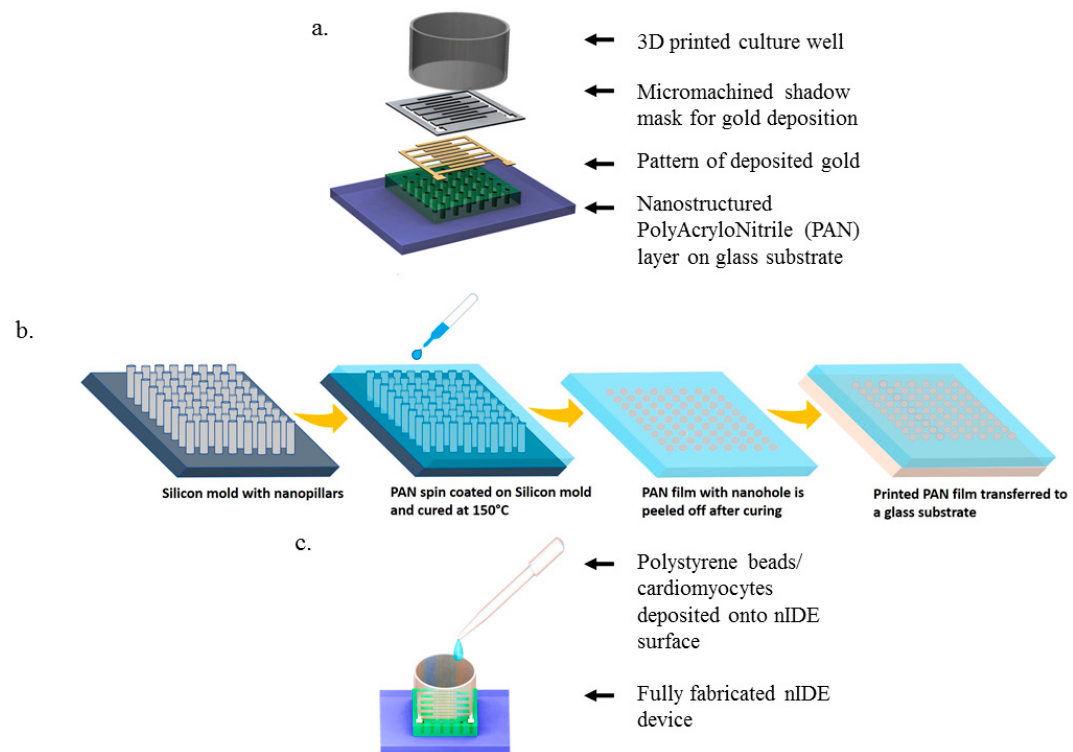
Figure 1. nIDE Nanofabrication and Device Assembly: ( a ) Schematic of nIDE device: A nanostructured polyacrylonitrile (PAN) layer is affixed to a glass substrate. A gold Interdigitated Electrode (IDE) structure is then patterned on top using a shadow mask. Finally, a 3D-printed culture well coated with PDMS is attached to enable the IDE to be used with biological specimens; ( b ) Process flow for spin-on nanoimprinting (SNAP) fabrication of PAN nanostructures; ( c ) Fully assembled device being plated with polystyrene beads/cardiomyocytes.